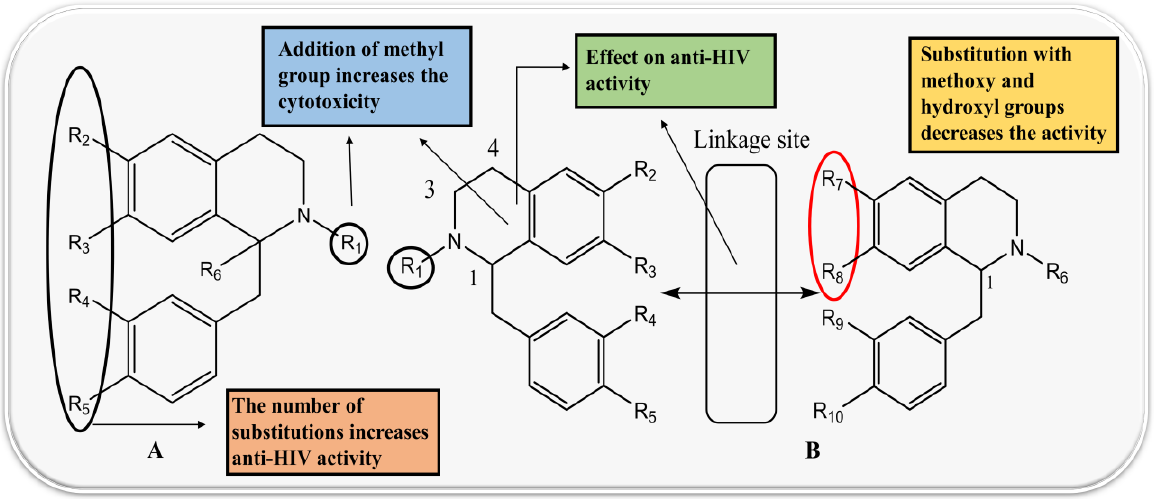
Figure 6. Structure–activity relationship of benzylisoquinoline ( A ) and bisbenzyl-isoquinoline alka- loids ( B